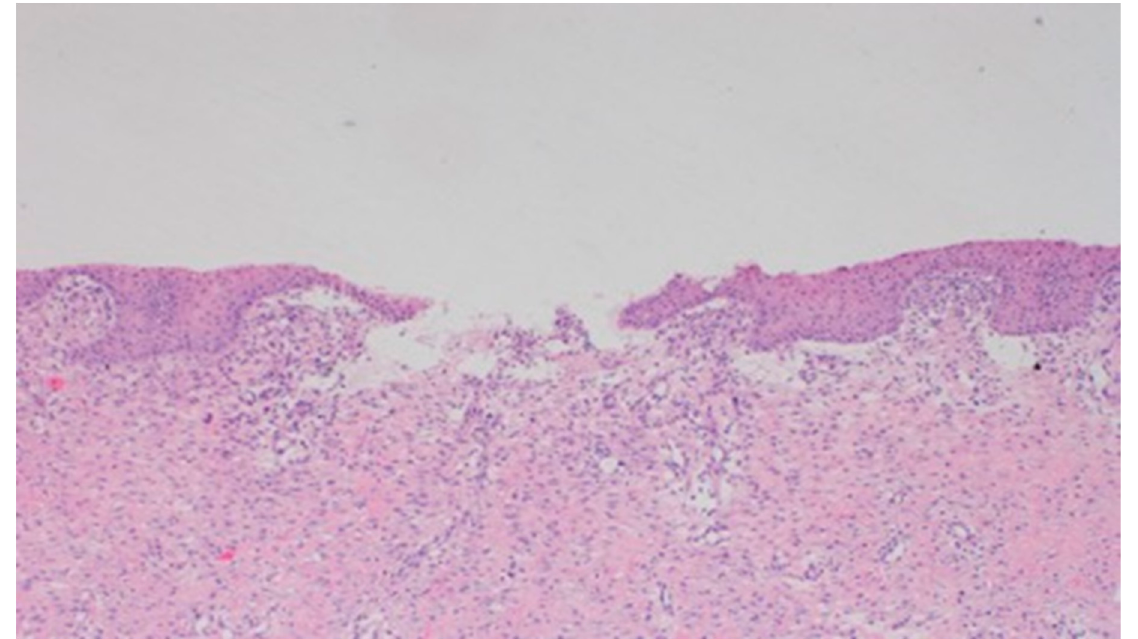
Figure 22. Skin wound, almost healed, without the inflammatory infiltration (40×, H-E), treated with the 1% propolis ointment, on day 25.